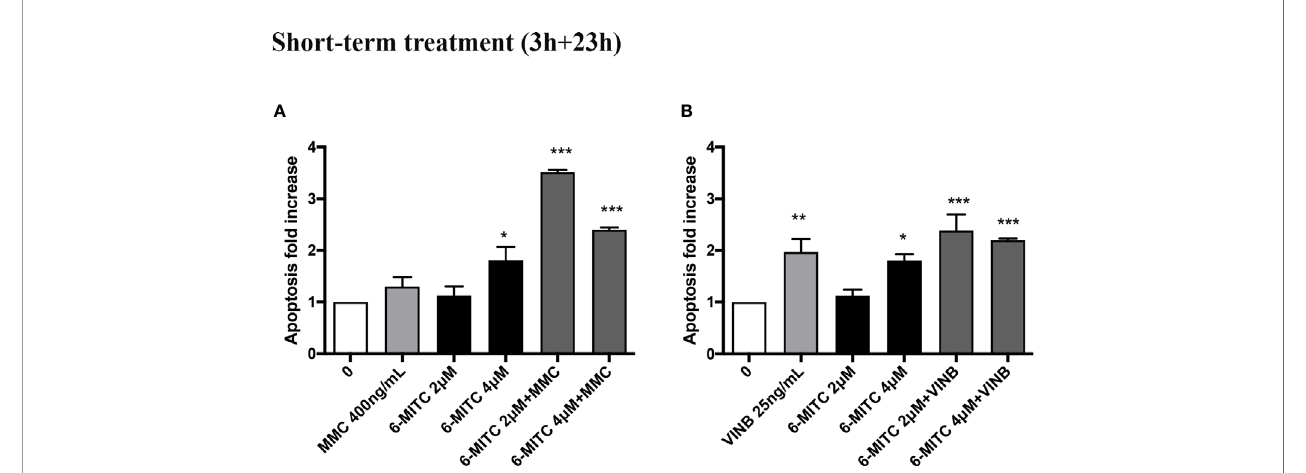
FIGURE 9 | Effect of 6-MITC on apoptosis after short term treatment. Apoptosis fold increase in TK6 cells treated with 6-MITC for 3h followed by 23h of recovery in complete medium in presence or absence of MMC 400ng/mL (A) or VINB 25ng/mL (B) . Each bar represents the mean ± SEM of fi ve independent experiments. Data were analysed using repeated ANOVA followed by Dunnet post-test. *p < 0.05 vs 0; **p < 0.01 vs 0; ***p < 0.001 vs